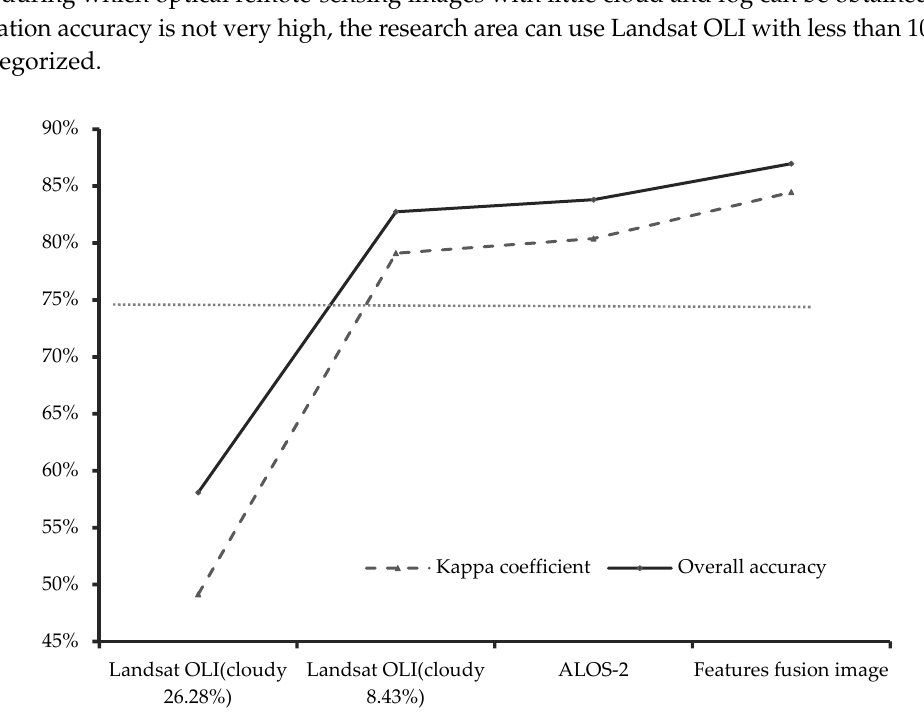
Figure 18. Improvement of the accuracy under different datasets.